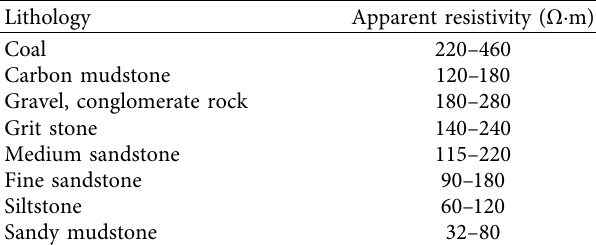
Table 1: Electrical parameters of coal and rock